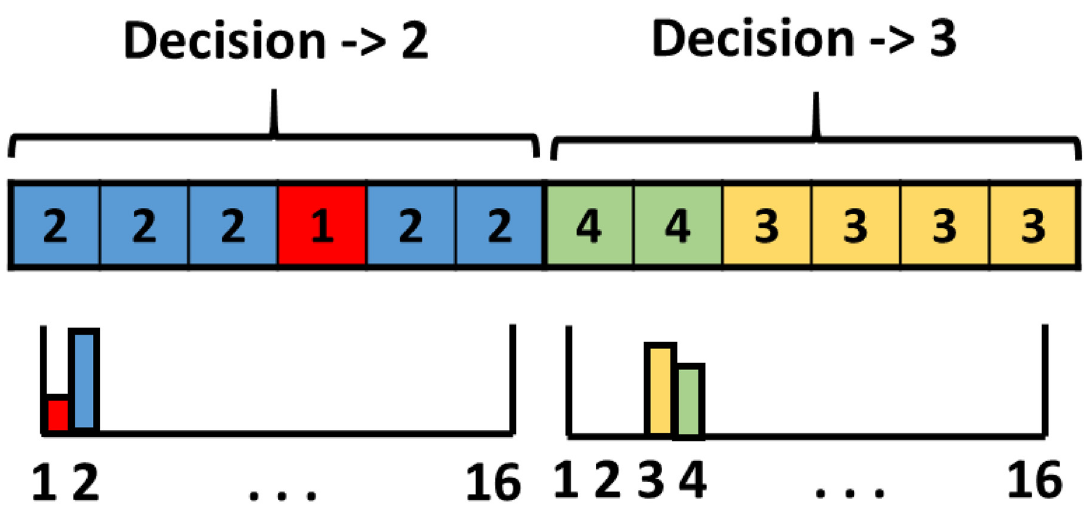
Fig 7. Example of the robust temporal feature vector of hand